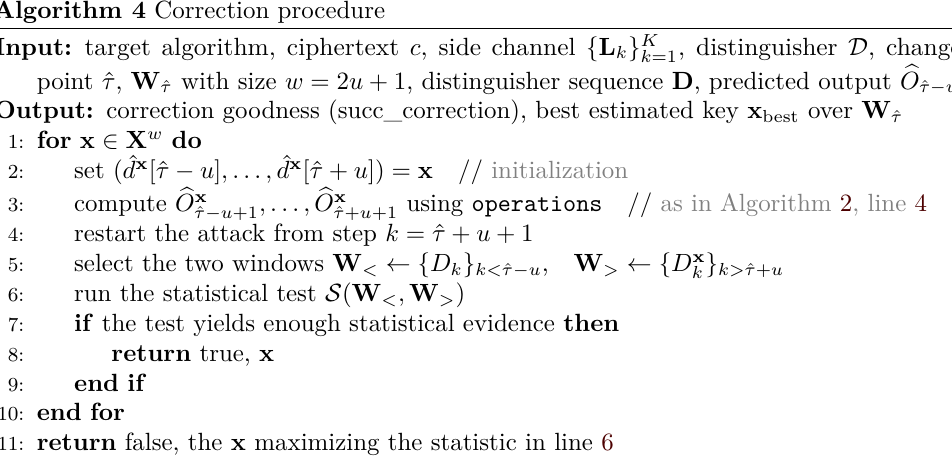
Algorithm 4 Correction